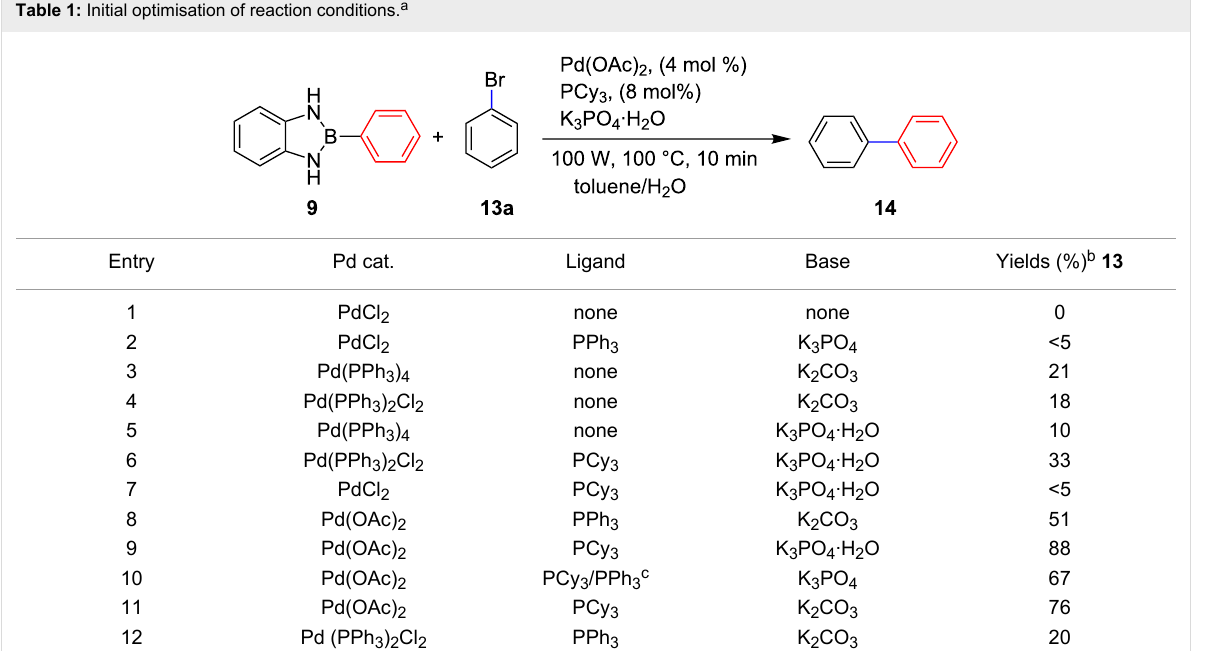
a Reaction conditions: compound 9 (0. 85 mmol), bromobenzene ( 13a , 0.77 mmol), Pd cat. (4 mol %), ligand (8 mol %), base (3 equiv), toluene (0.50 mL) and water (0.1 mL). Closed vessel, 80 W of microwave energy, 100 °C, 100 psi of pressure, 10 minutes. b Isolated yields after column chro- matography. c 4 mol % each of the ligands.